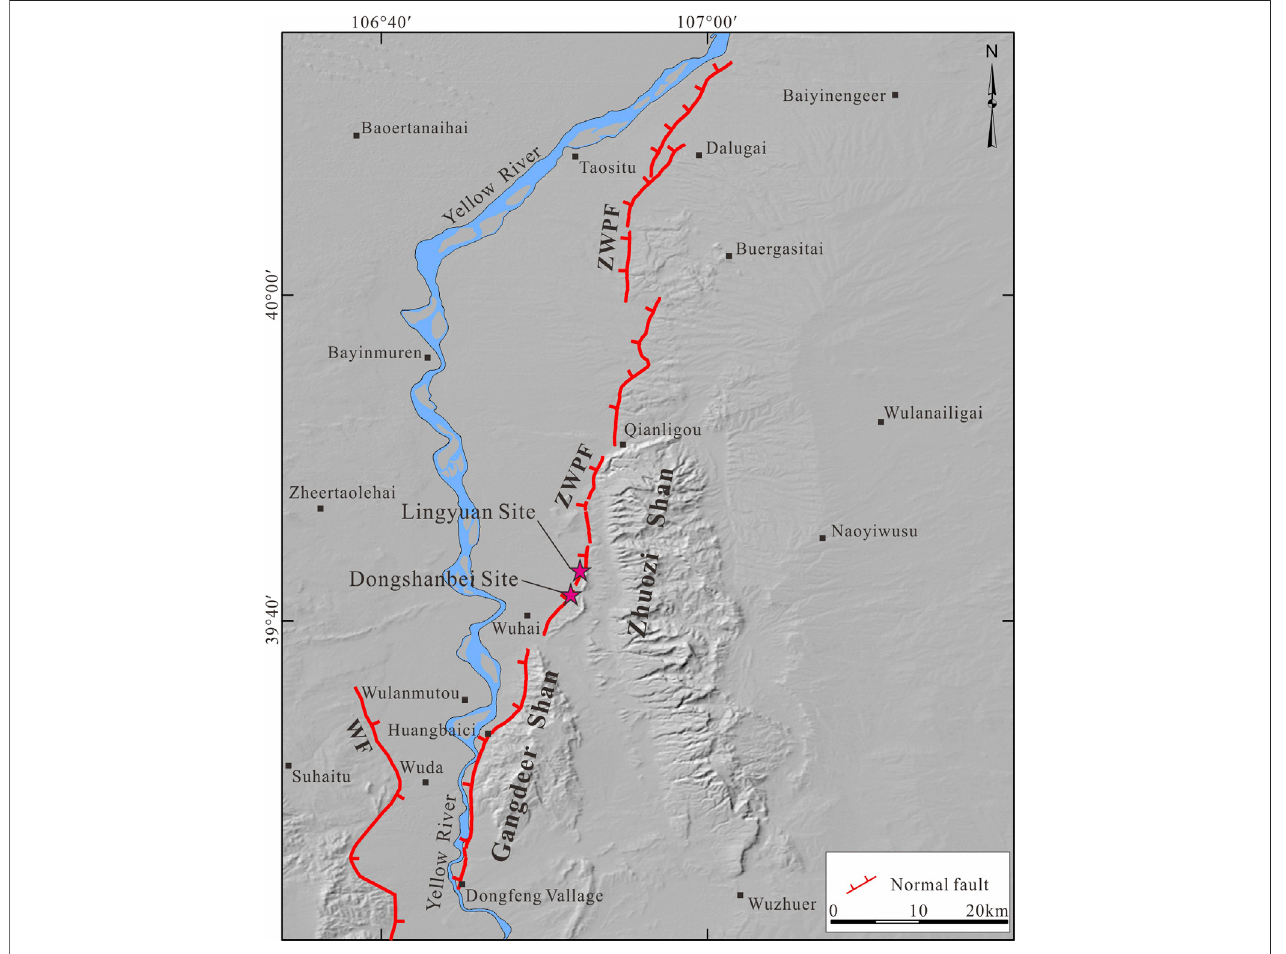
FIGURE 2 | Hill-shaded relief map showing the location of the Zhuozishan Piedmont Fault and its adjacent region. Abbreviations of names of active faults: ZPWF, Zhuozishan Piedmont Fault; WF, Wuhushan Fault.